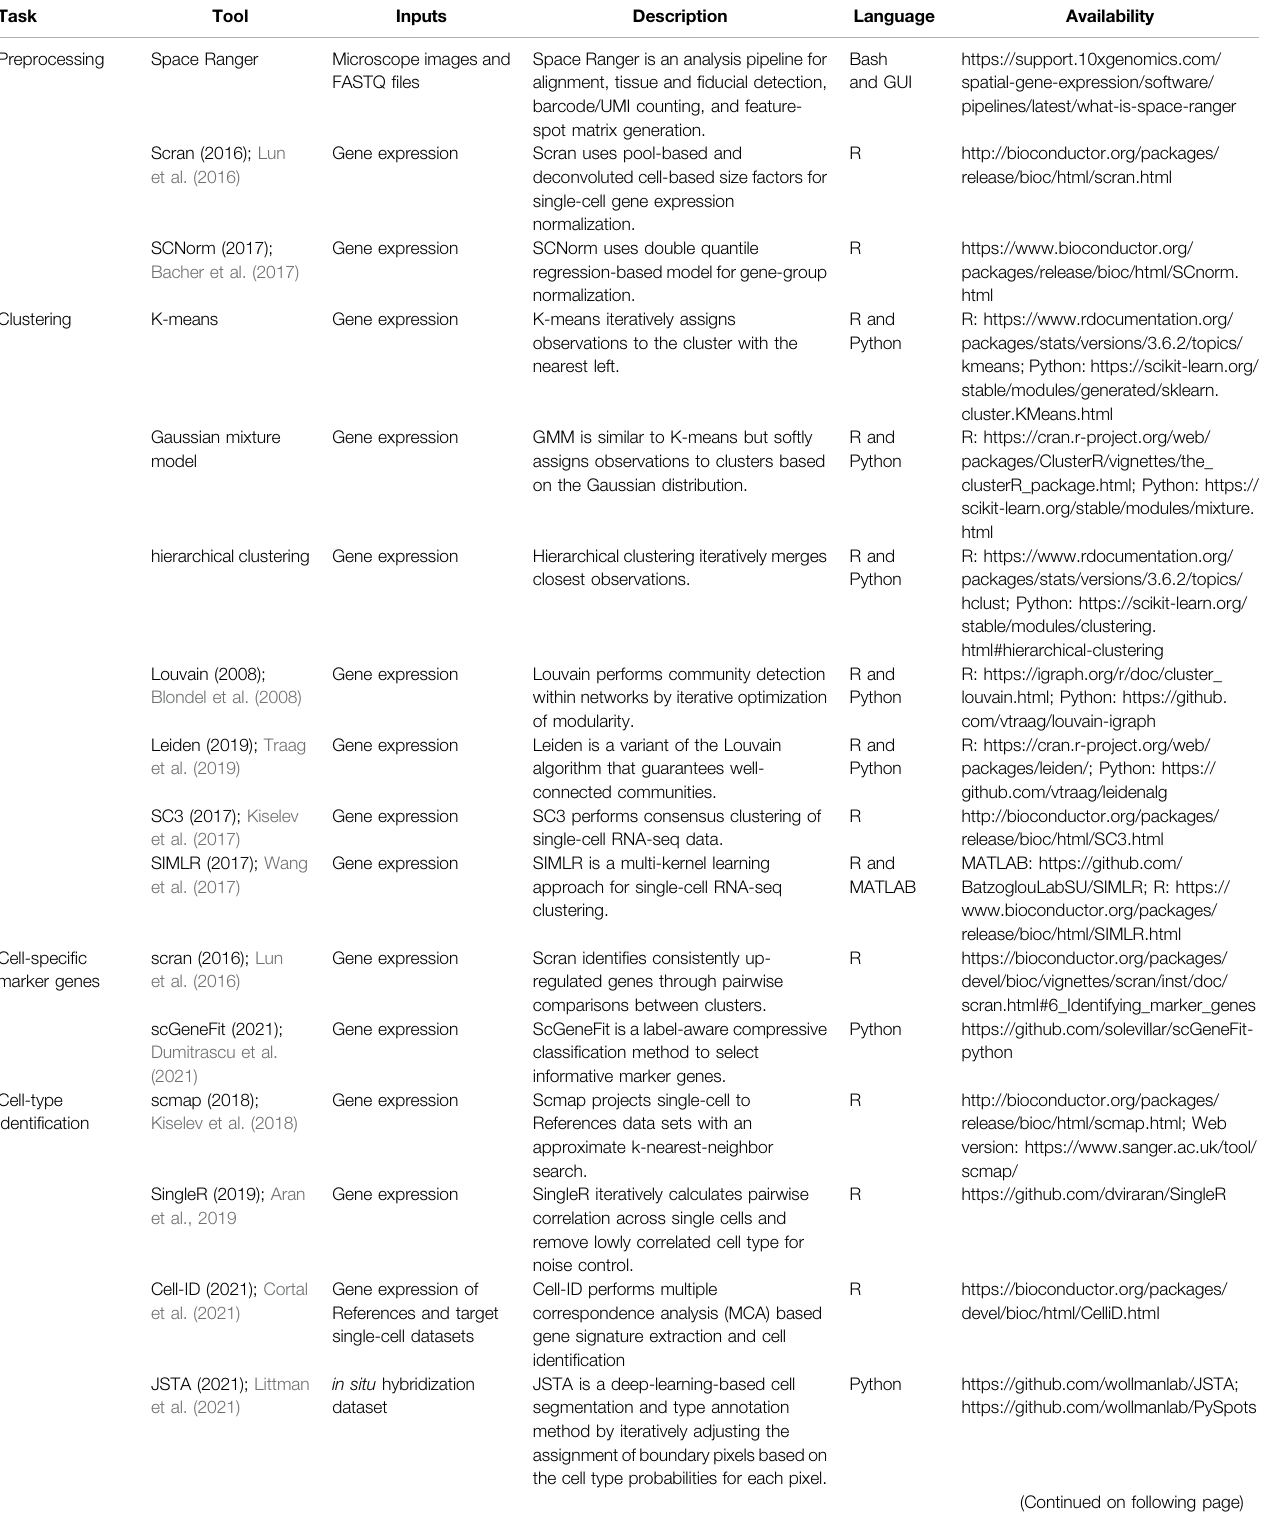
TABLE 1 | Current analysis and visualization tools for spatial transcriptomic datasets (accession date: